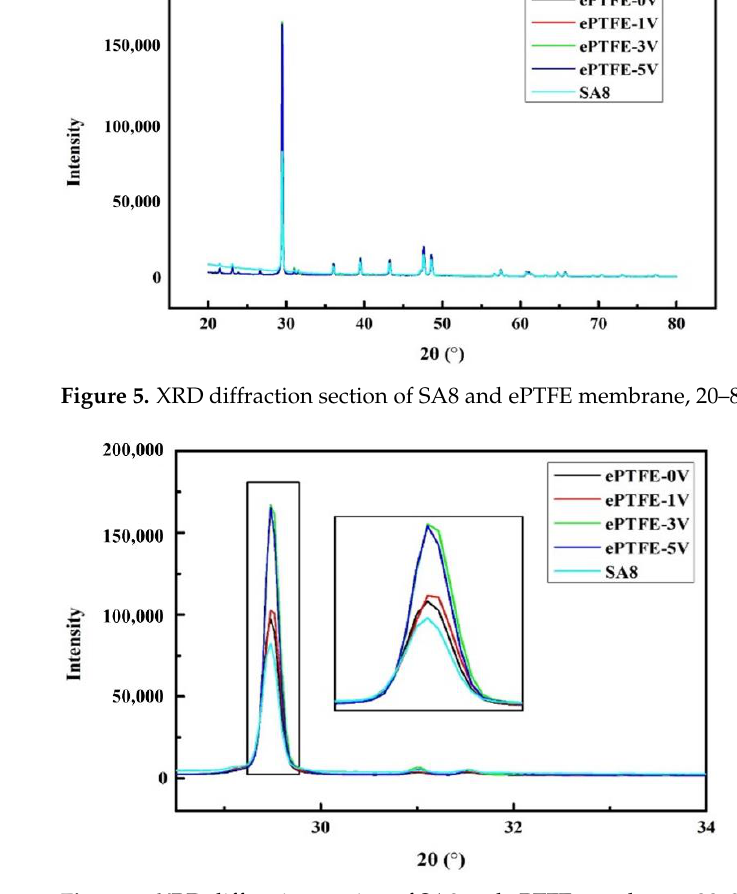
Figure 6. XRD diffraction section of SA8 and ePTFE membrane, 28–34 ◦ .